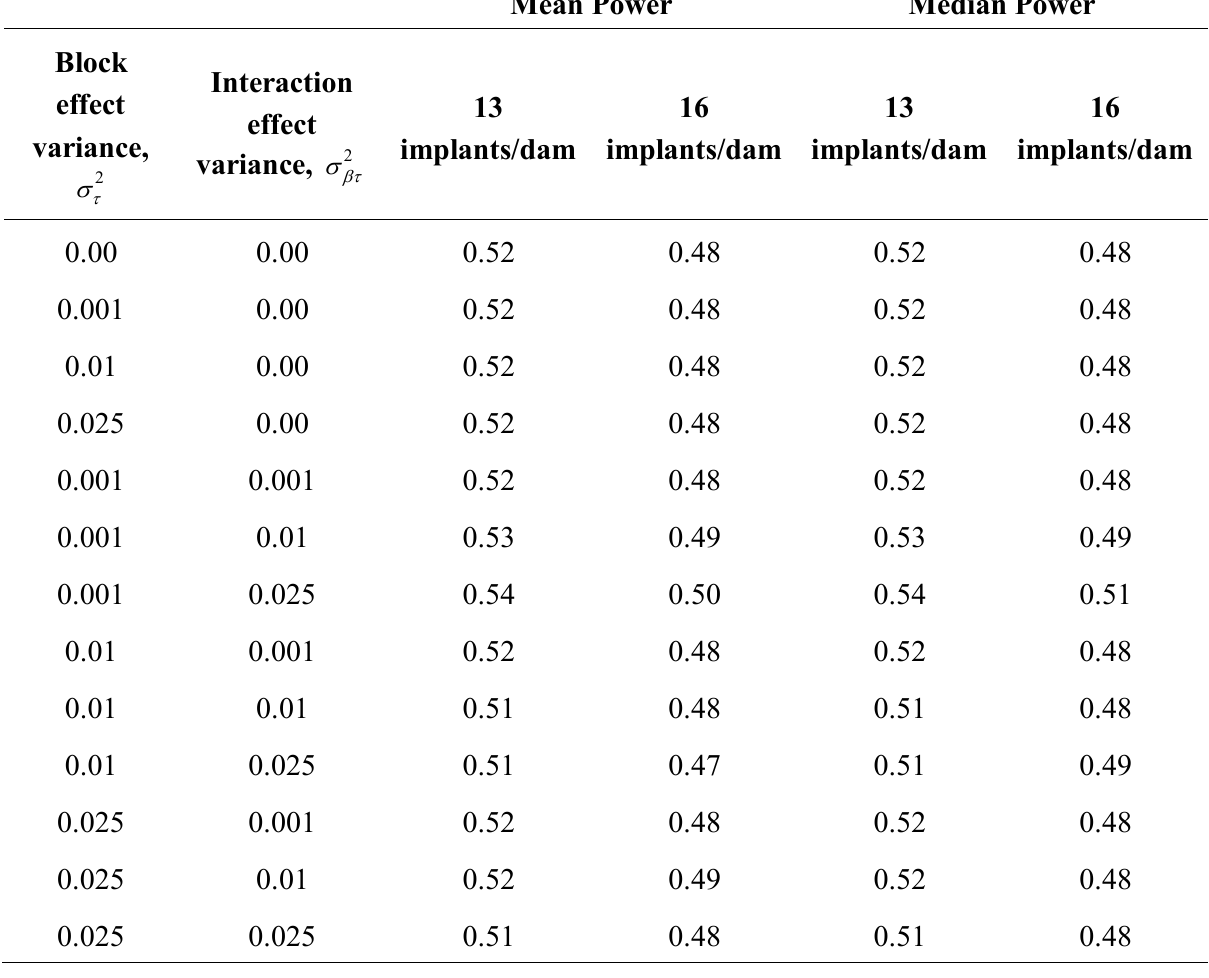
Table 4. Power to detect a 1.9-fold difference in prenatal loss using a linear logistic model: Two-block